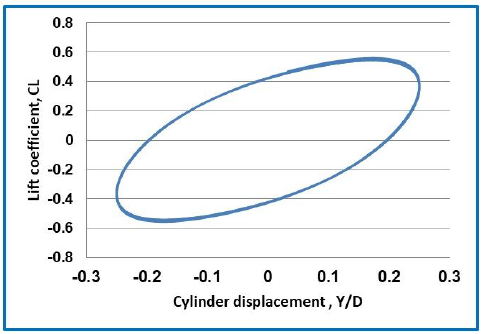
Figure 16: Lift coeflcient history at f v = 2 f s , inline flow vibration